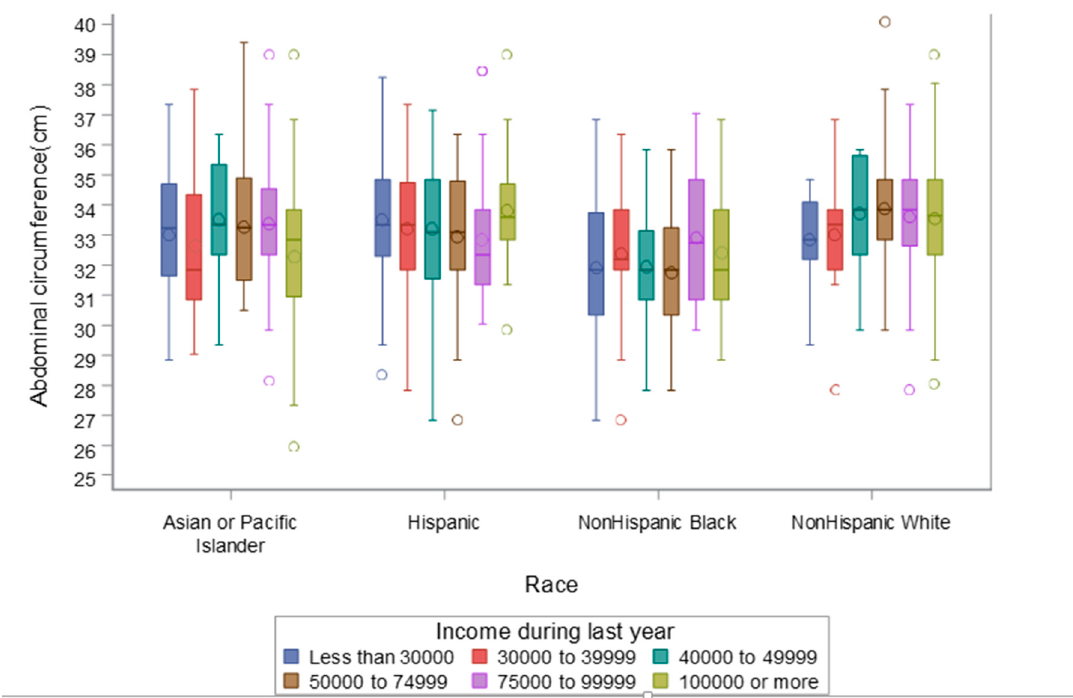
Figure 1. Income level differences in fetal abdominal circumference by race.